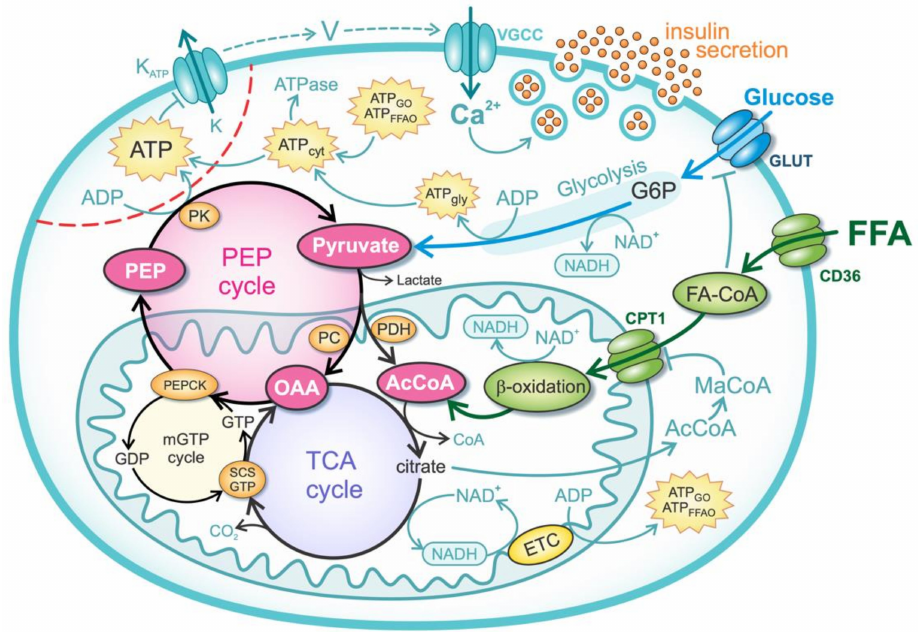
Figure 1. Schematic representation of a mathematical model. ATP—ATP concentration near K ATP channels, ATP cyt —cytosolic ATP concentration, ATP gly —net glycolytic ATP production, ATP FFAO — total ATP production by FFA metabolism, ATP GO —ATP production by oxidation of pyruvate and reducing equivalents from glycolysis, AcCoA—acetyl-coenzyme A, CD36—transmembrane FFA transport protein (FFA translocase), CPT1—carnitine palmitoyltransferase 1, ETC—electron